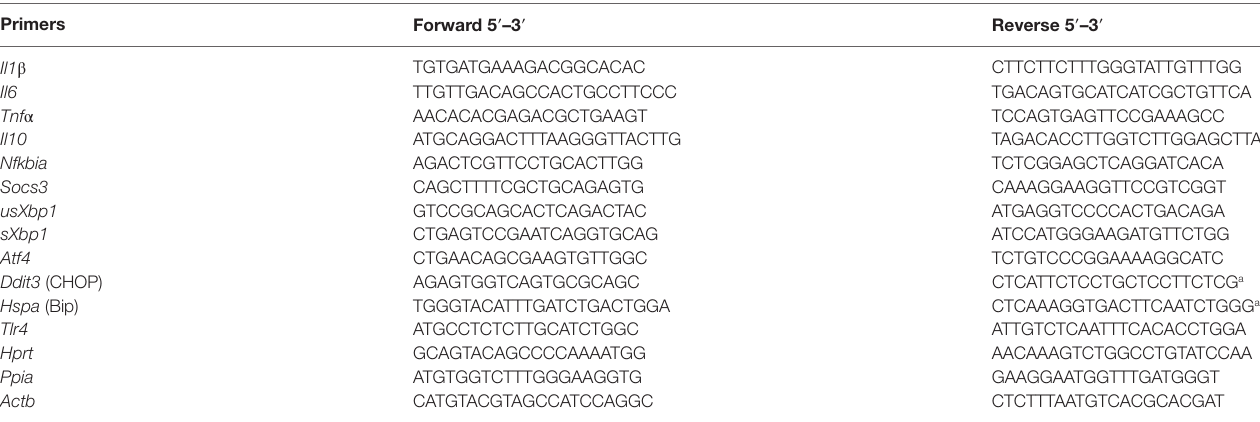
Table 1 | Primer sequences used for reverse transcriptase